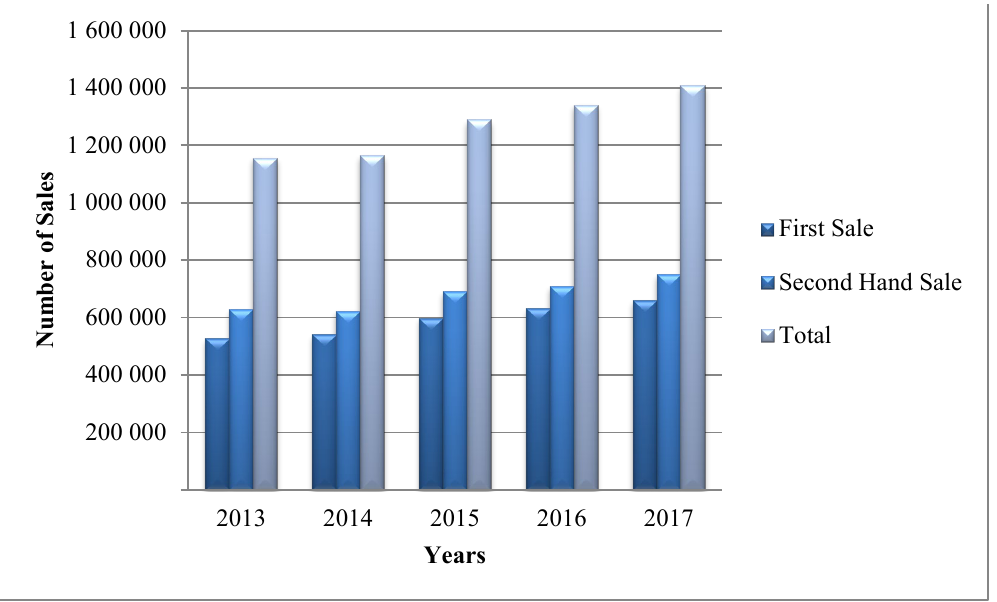
Fig. 1. House sales in detail of first sale and second-hand sale by years, in Turkey, 2013–2017 (developed by the